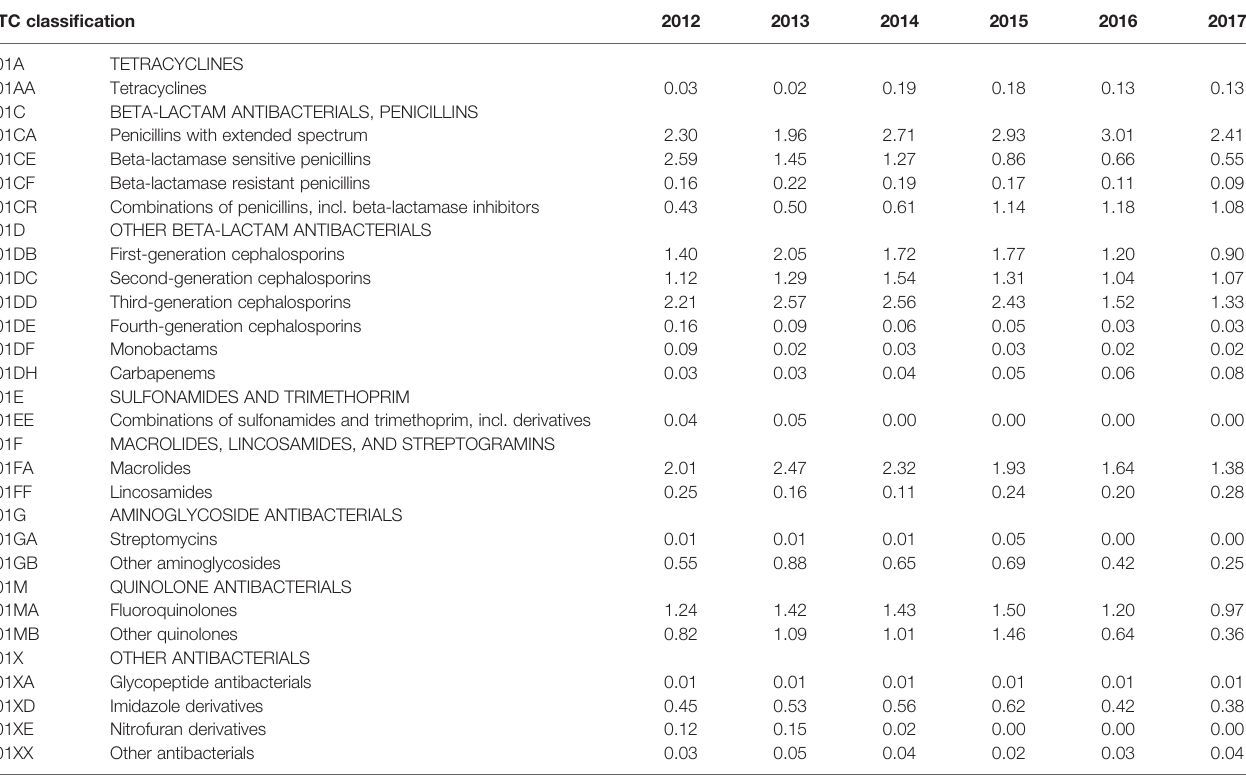
TABLE 1 | Antibiotic consumption by ATC-4 classi fi cations in Shandong, 2012 – 2017 a